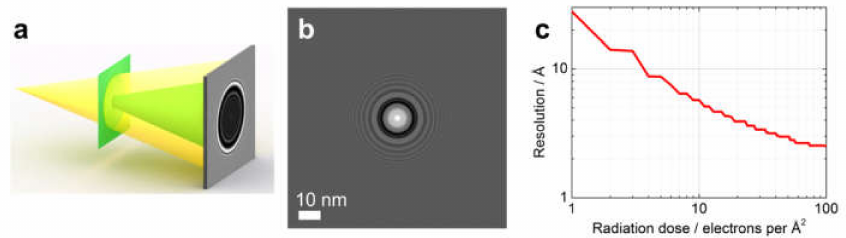
Figure 28. Radiation dose required to achieve a given resolution in in-line holography. ( a ) Experimental scheme for in-line holography. ( b ) Simulated in-line hologram of a round phase object of 10 nm in diameter. ( c ) Resolution as a function of radiation dose in in-line holography.